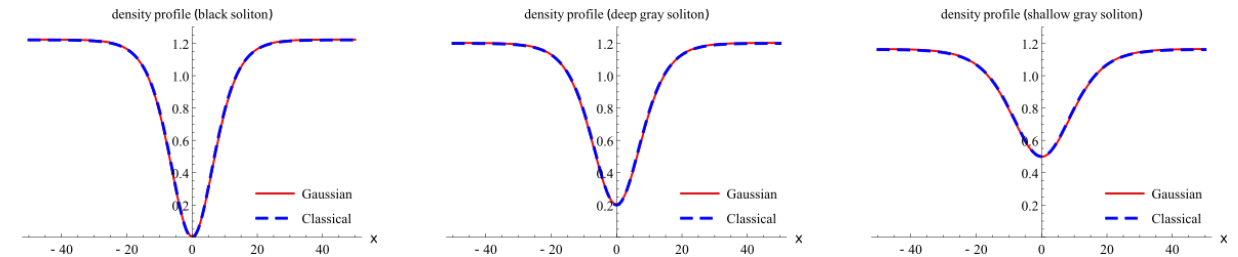
Figure 2. Comparison of the density profiles of quantum soliton states | N ,0; P (cid:105) superposition of yrast states) and those of classical dark solitons, for P = π n ( left ), P = 0.4502 π n ( middle ) and P = ( π /2 − 1 ) n ( right ). The vertical axis represents the local density of particles, whose average is equal to N / L . The system size is set as N = L = 100, and c =